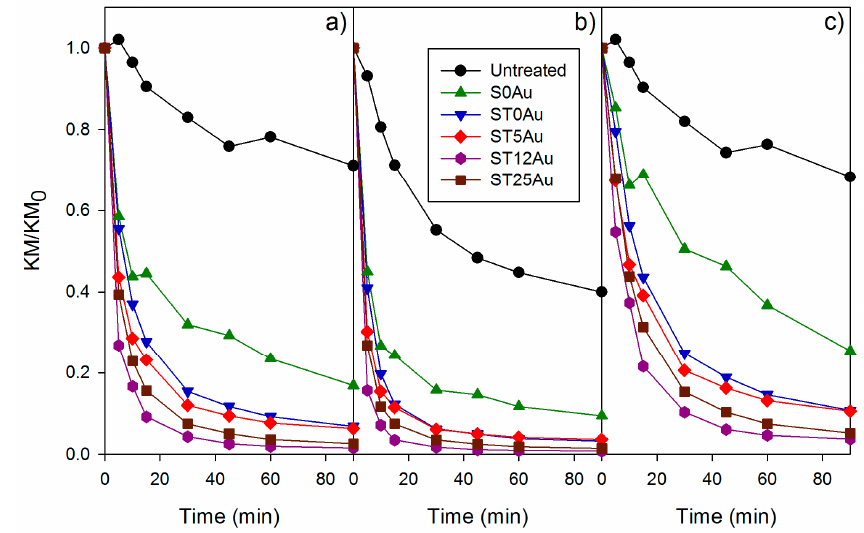
Figure 10. Evolution of KM/KM 0 for the untreated and treated stone samples stained with methylene blue, ( a ) overall degradation; ( b ) monomer degradation and ( c ) dimer degradation.